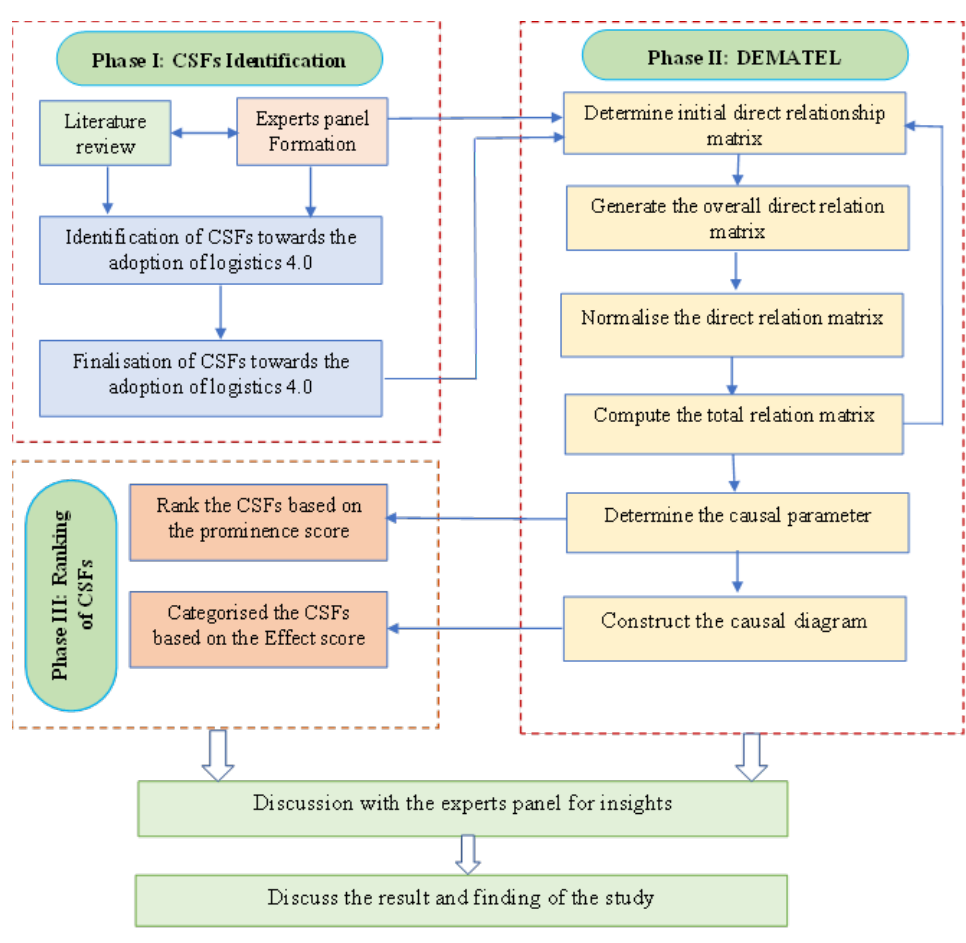
Figure 1. Research framework for this study.